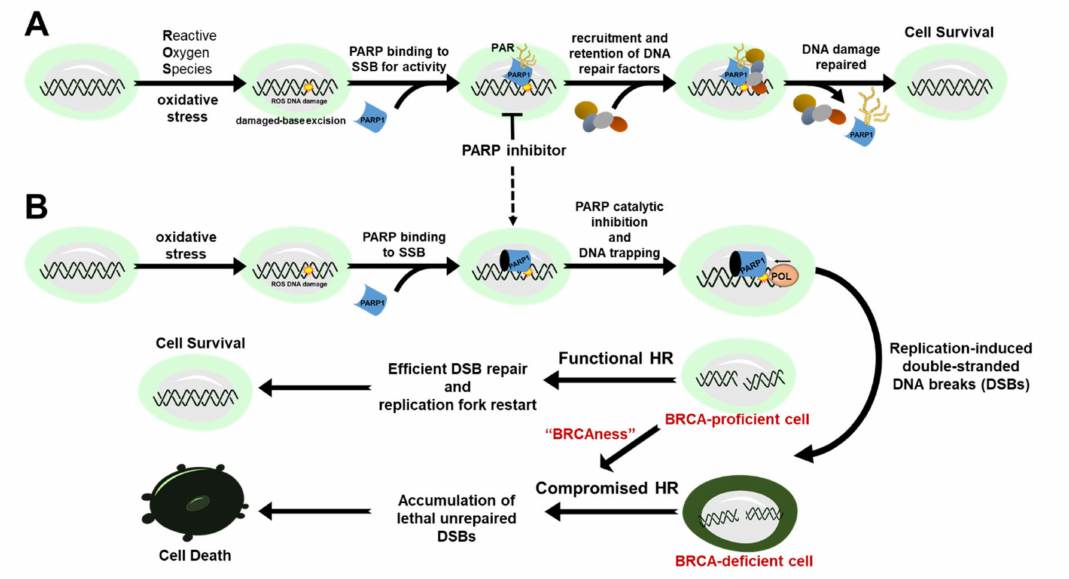
Figure 1. The role of PARP1 in DNA damage response and repair and cancer therapy. ( A ) PARP1 binds to single-strand breaks (SSB) for activity to target, recruit and retain critical DNA repair proteins at the sites of DNA lesions. ( B ) PARP inhibitors convert SSBs to lethal double-stranded breaks (DSBs) that are left unrepaired in BRCA-deficient cells due to a compromised homologous recombination (HR) repair consequently leading to cell